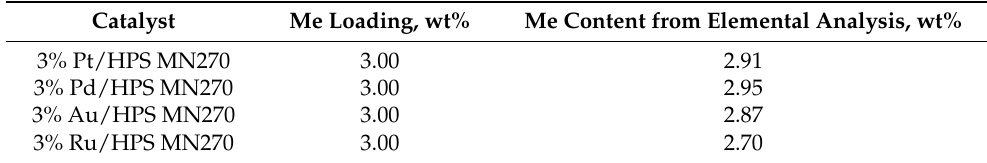
Table 1. Results of X-ray fluorescence analyses of the synthesized catalysts.